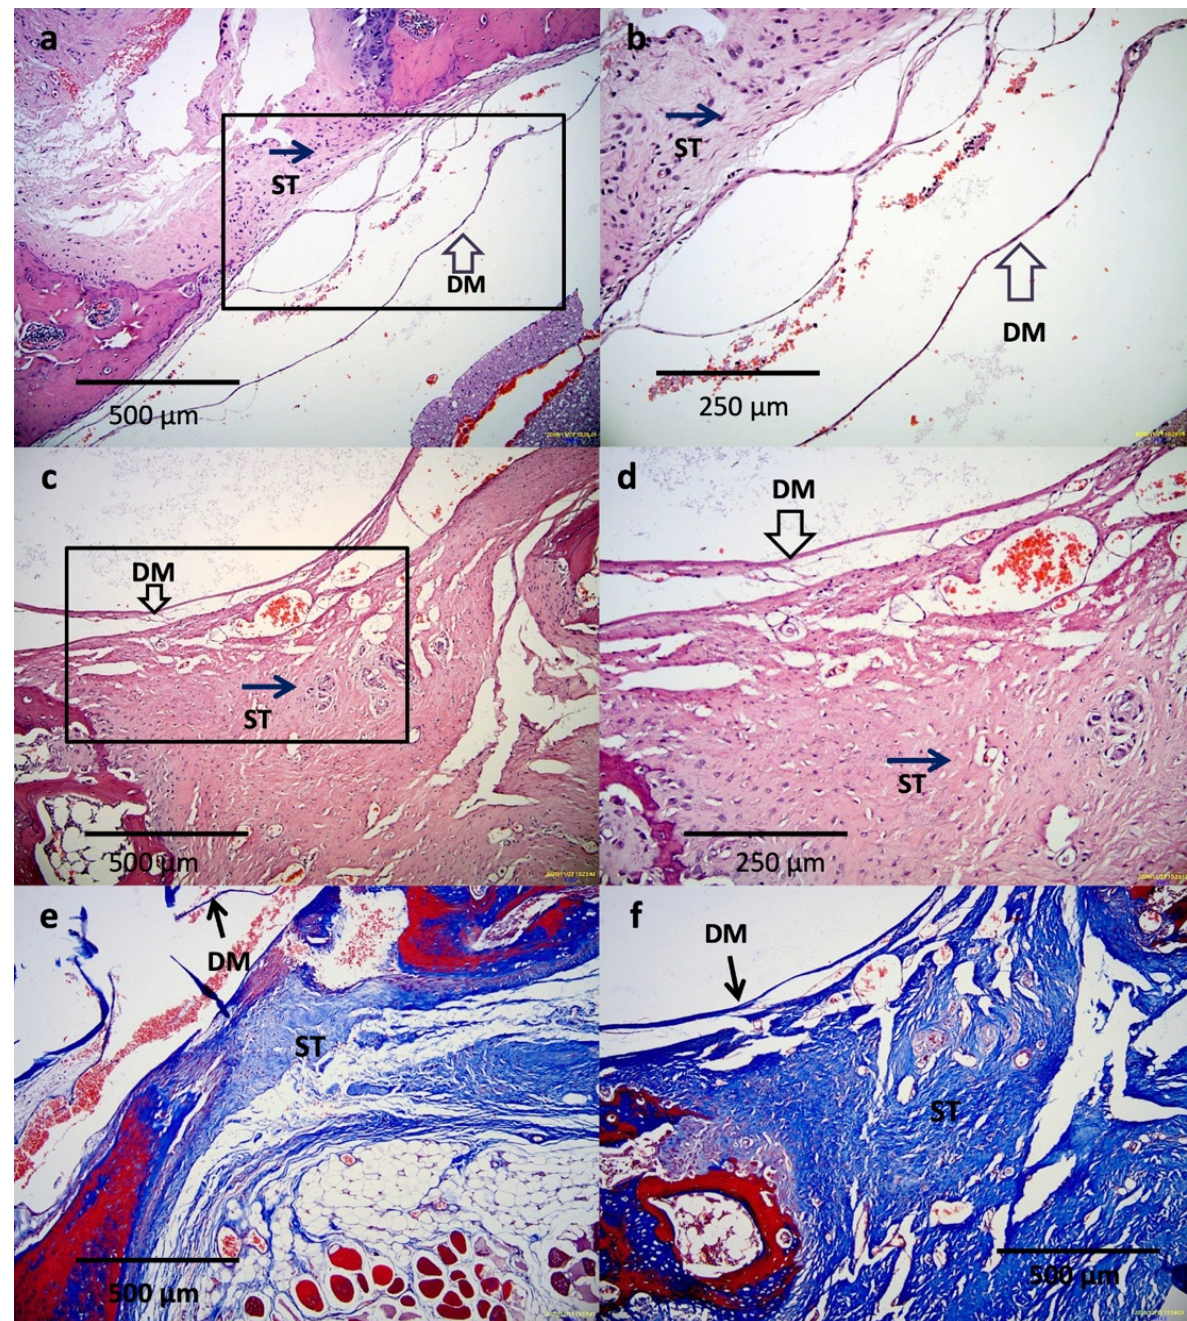
Figure 10. Histology results at 8 weeks post-laminectomy. ( a ) 100 × and ( b ) 200 × H&E-stained image of a specimen of the treatment group. There were only thin fibrotic bands between the scar tissue and dura mater. ( c ) 100 × and ( d ) 200 × H&E-stained image of a specimen of the control group. Large-area fibrotic adhesion in the epidural defect was observed. ( e ) 100 × Masson’s trichrome-stained image of a specimen of the treatment group. There were increased collagen fibers compared with ( f ) 100 × image of the control group. (ST: scar tissue, DM: dura